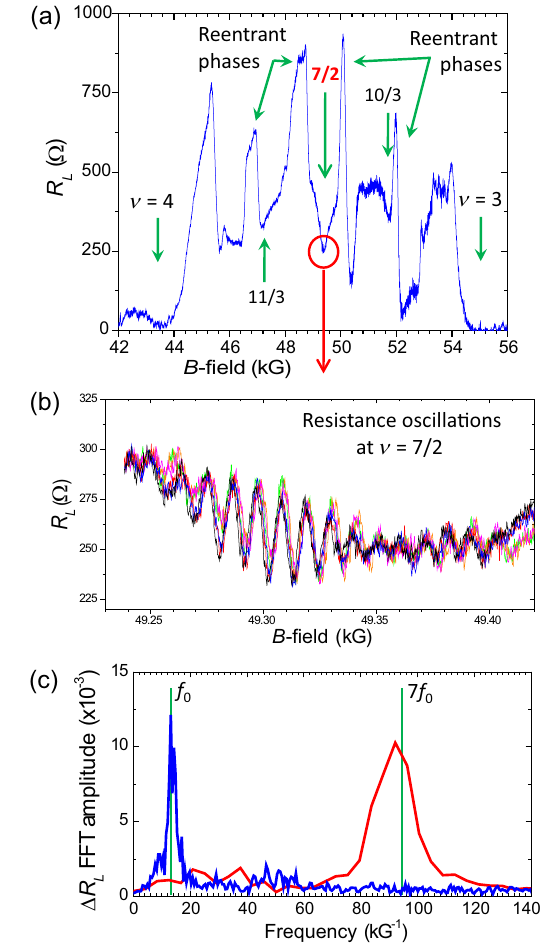
FIG. 3. (a) Longitudinal resistance R measured across the L interferometer between filling factors ν ¼ 3 and ν ¼ 4 in an ultrahigh-mobility heterostructure. Integer and fractional quantum Hall states as well as phase-separated (nematic) states are labeled. Temperature approximately 20 mK, sample 6, preparation 16, B Þ near the filling factor device type b. (b) An enlargement of R L ð 7 = 2 demonstratinglarge-amplitudeinterferenceoscillations.Trace setsshowoscillationsnear ν ¼ 7 = 2 forbothup-anddownsweepsof magnetic field B . The set of six sweeps shown here covers a time of 8.75 hours, 87.5 minutes for each directional sweep. The data demonstratebothahighlevelofreproducibilityandstabilityforthe time and magnetic field ranges over which the data are taken. See also Figs. S5-2 – S5-4 in the Supplemental Material [34]. (c) A Fourier transform of these oscillations (red) overlayed with the Fourier transform of oscillations observed at ν ¼ 3 (blue). Vertical greenlinesmarkthefrequency f 0 oftheintegerspectralpeakandits multiple 7 f 0 , the expected frequency of the non-Abelian even-odd effect at ν ¼ 7 = 2